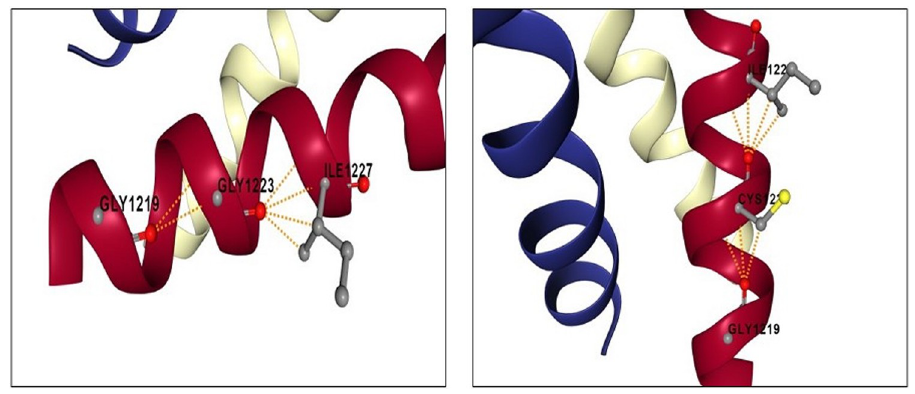
Fig 4. Variations in the intramolecular interactions in transmembrane domain of wild type and mutant spike protein. Intramolecular molecular interactions (yellow dotted line) in ribbon diagrams of the transmembrane domain of wildtype (G1223) and variant (C1223) SARS-CoV-2 spike